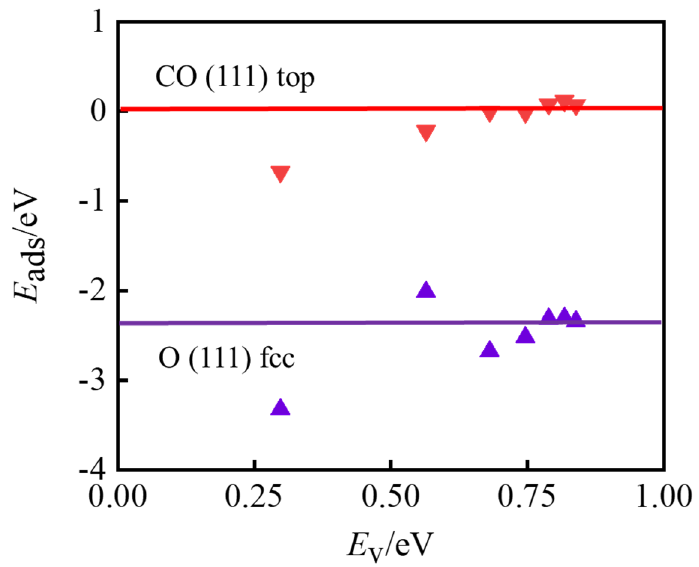
Figure 8. Relationship between vacancy formation energy and adsorption energy. (The red and blue lines in the diagram, respectively, indicate the adsorption energy of the block Au for CO and O for slab surface calculations. The points are collected from [54].)